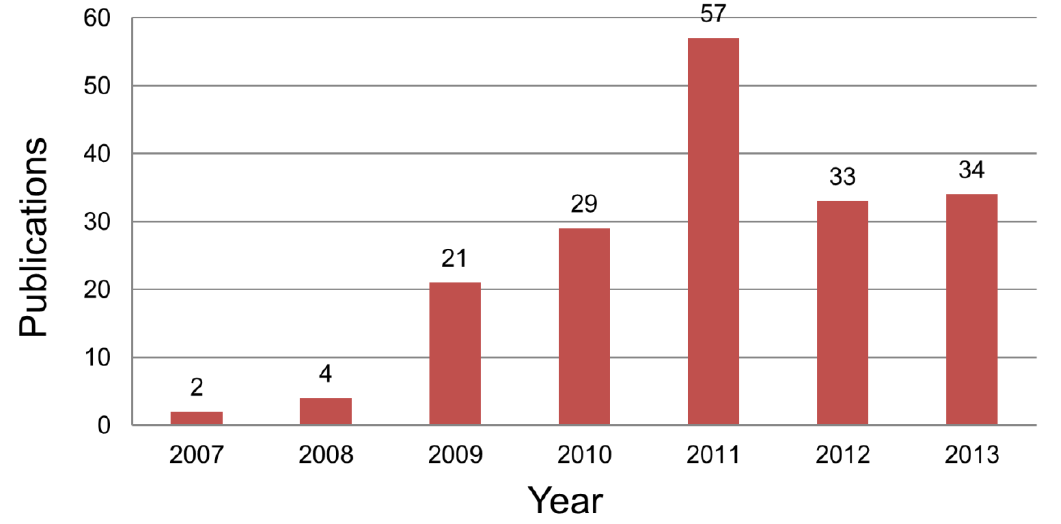
Figure 2. The number of publications over seven years (2007–2013). The results include conference papers, but exclude articles not related directly to BCI games. The search was conducted through October